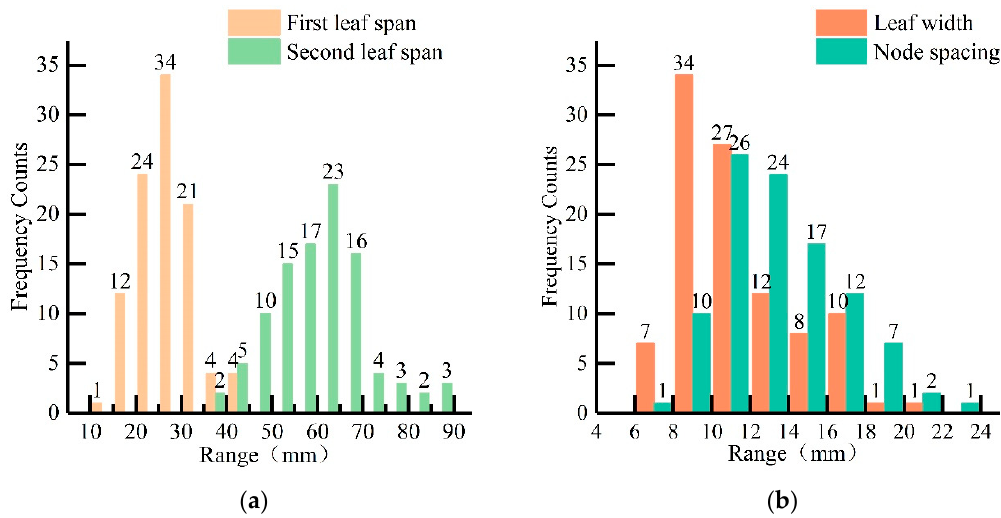
Figure 5. Frequency distribution of dimension parameters. ( a ) Frequency distribution of first leaf span a and second leaf span b , ( b ) Frequency distribution of leaf width c and node spacing d .